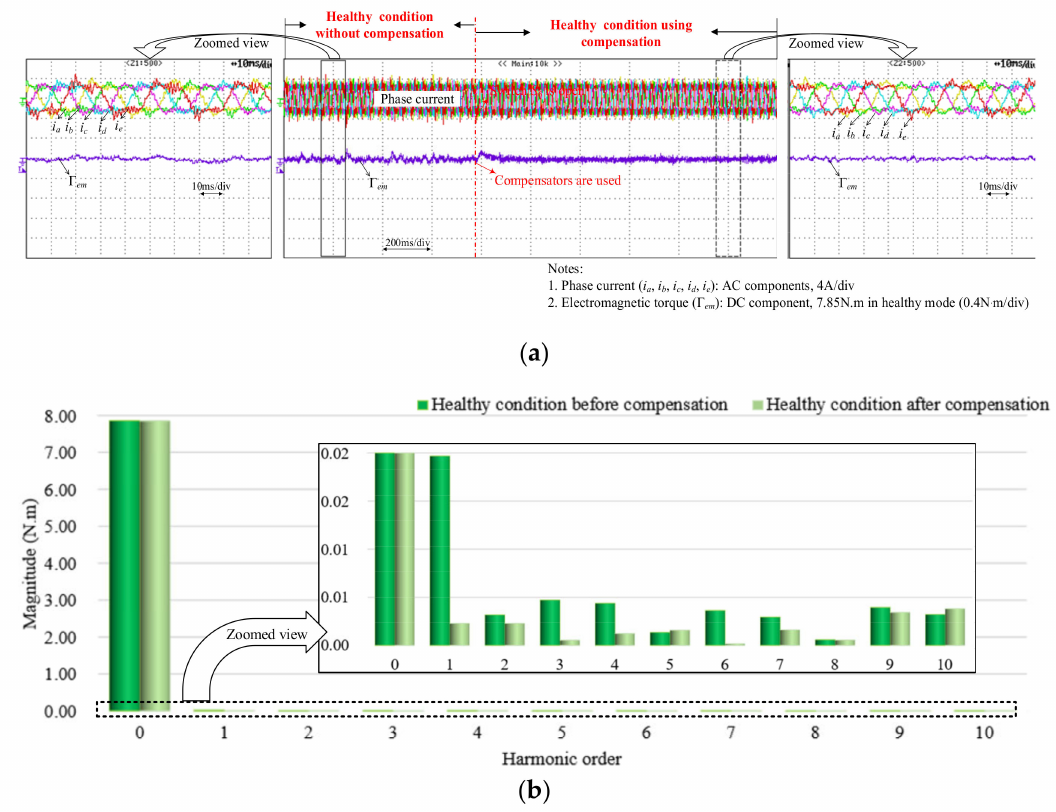
Figure 10. Experimental test of disturbance suppression by proposed strategy in healthy conditions: ( a ) Waveforms recorded by oscilloscope, ( b ) Spectrum